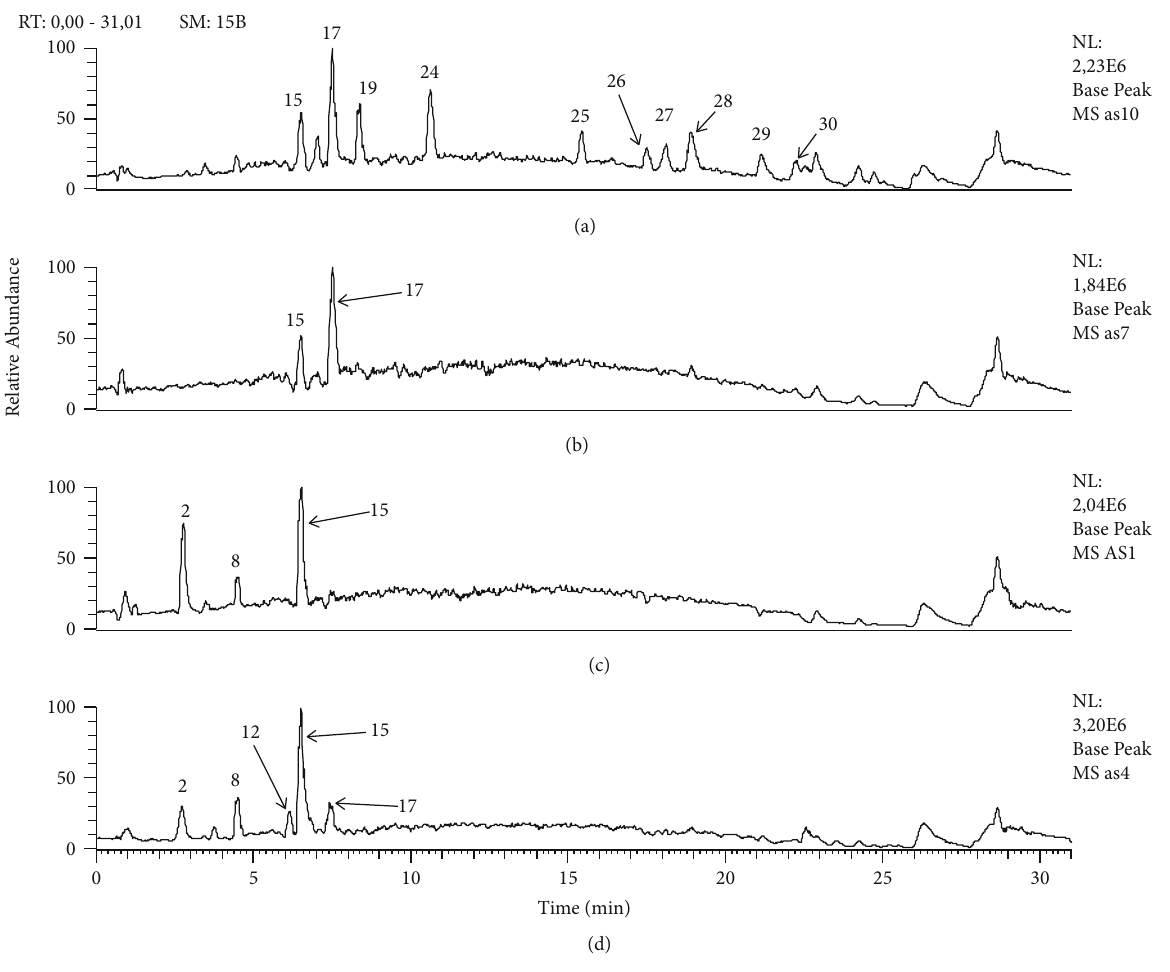
Figure 2: Comparative base peak chromatograms of all extracts from major identi fi ed metabolites, Olea europaea var. meski organs. (a) Stones (methanol); (b) stones (methanol/H O); (c) seeds (methanol); (d) seeds (methanol/H2O). 2: hydroxytyrosol; 8: oleoside 2